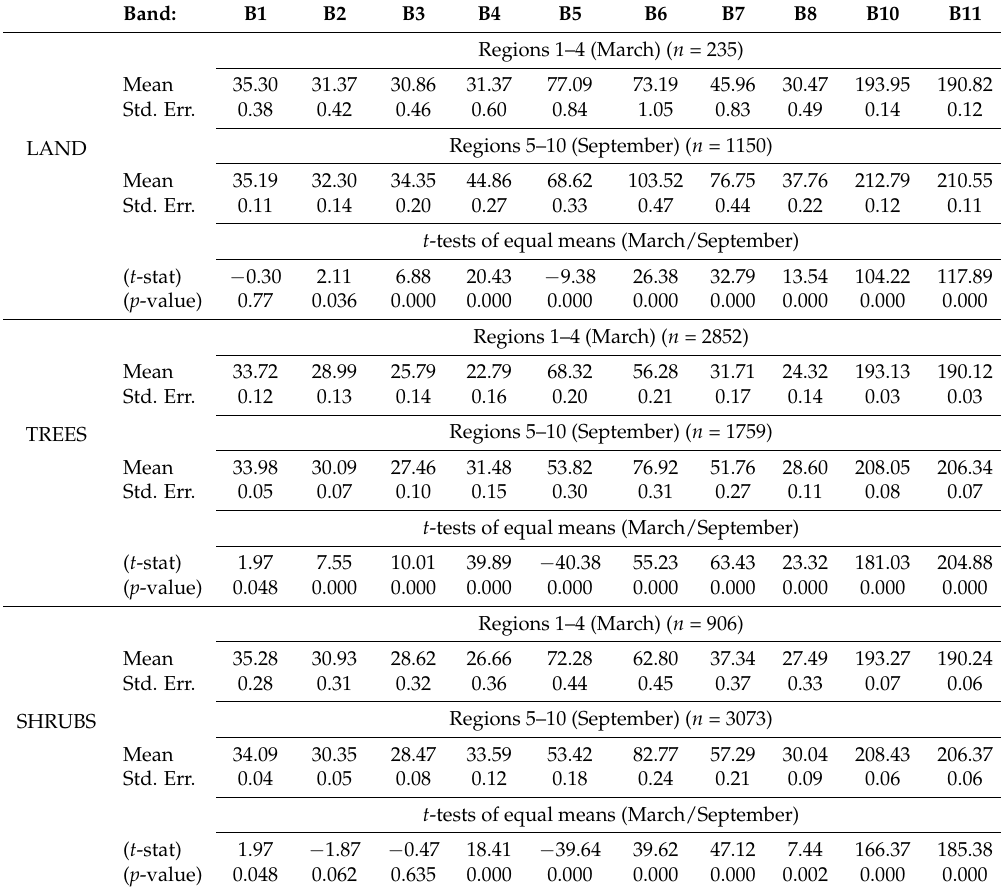
Table A3. Statistics for Landsat 8 reflectance values of training data set, per class and season ( p -values shown for 95% confidence